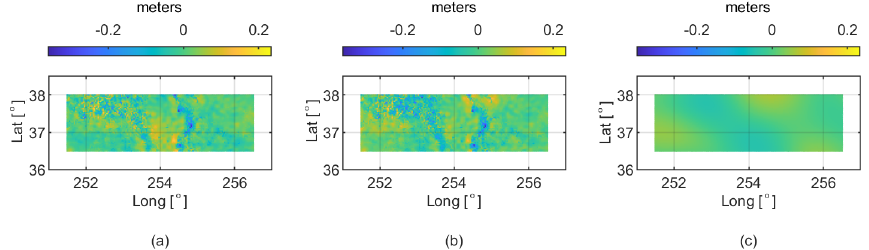
Figure 9. Difference between the analysed Colorado geoids: (a) ColWLSC2020–EIGEN-6C4, (b) ColWLSC2020–EGM2008, and (c)